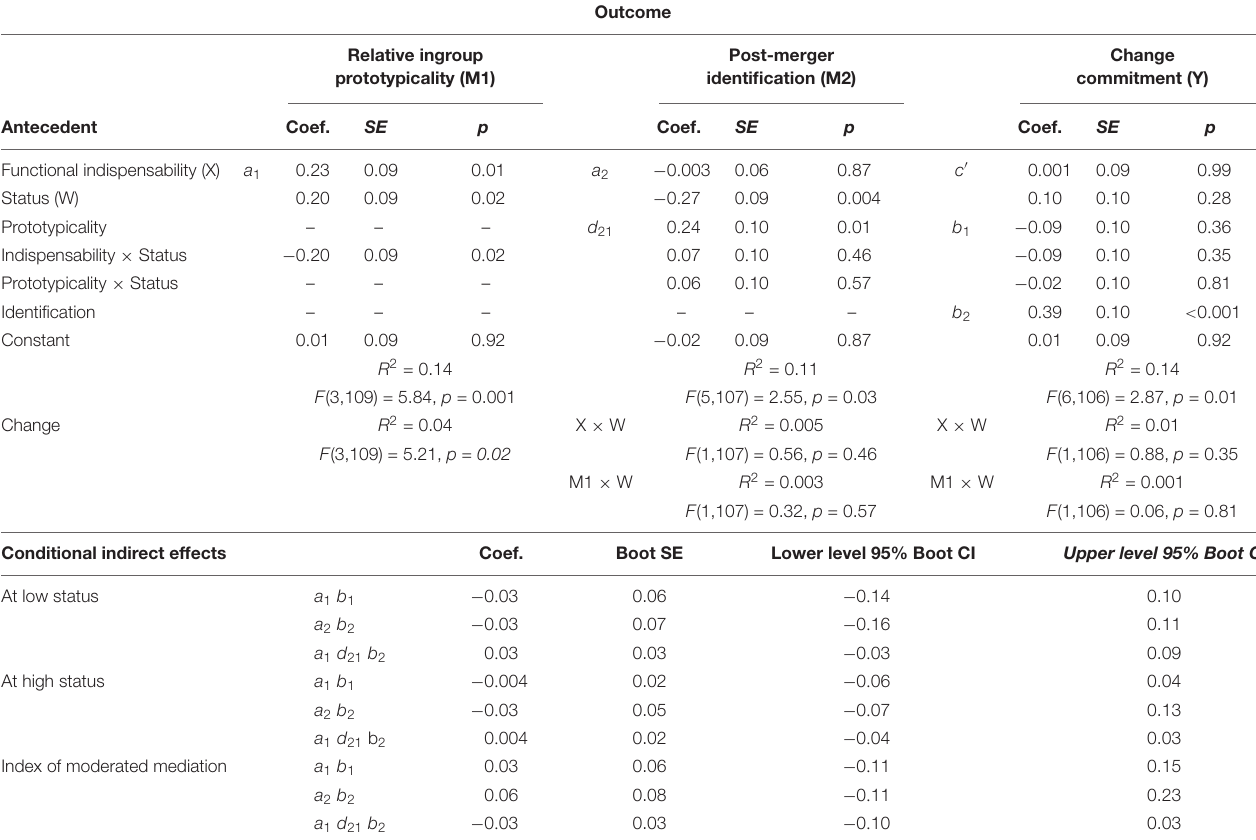
TABLE 5 | Summary of sequential mediation, Study 4 (moderated by